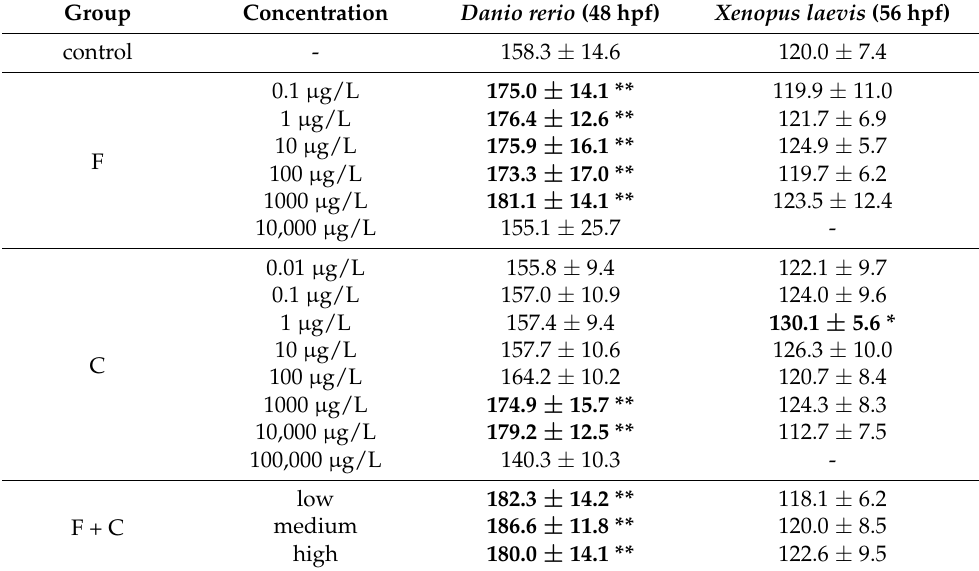
Table 5. Embryonic heart rate (beats per minute—bpm) of zebrafish ( Danio rerio ) and African clawed frog ( Xenopus laevis ) embryos exposed to antidepressants as single substances and as a mixture. The results are expressed as mean ± standard deviation. Bold font and asterisks indicate a significant difference (* p < 0.05, ** p < 0.01) between the control and experimental groups at the same time of exposure. Group Concentration Danio rerio (48 hpf) Xenopus laevis (56 hpf) control - 158.3 ± 14.6 120.0 ± 7.4 0.1 µ g/L 175.0 ± 14.1 ** 119.9 ± 11.0 1 µ g/L 176.4 ± 12.6 F